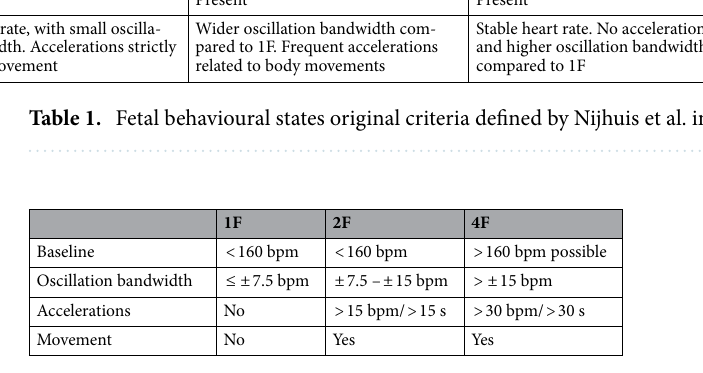
Table 2. Fetal behavioural states definition criteria by Brändle et al. from 2015 9